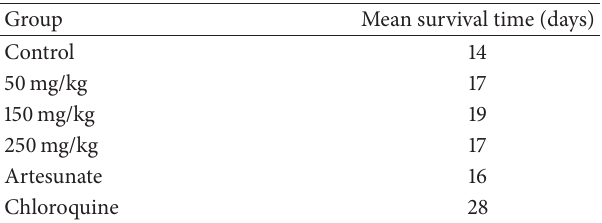
Table 3: Mean survival time of animals for the experiment. Group Mean survival time (days) Control 14 50 mg/kg 17